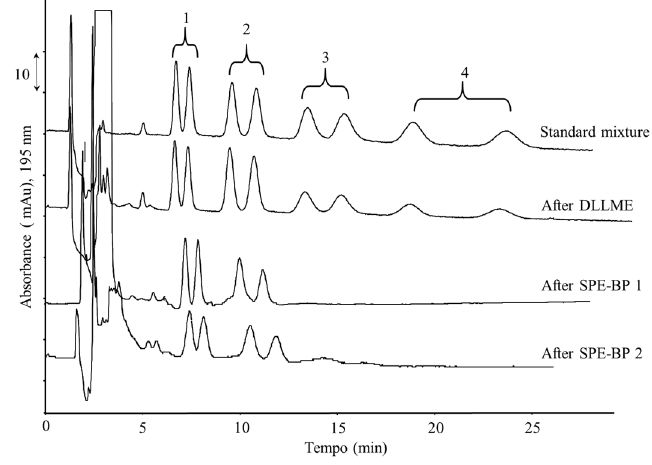
Figure 5. Chromatograms of Milli-Q water spiked with a multistandard solution: mix standard solution; DLLME with a mixture of ACN/CH 3 Cl (500/300 µL) as the dispersing and extracting solvent, respectively; SPE-BP 1, with desorbing solvent MeOH; SPE-BP 2 with desorbing solvent [(CH 3 ) 4 N]Cl hydrate 10 mM MeOH. Experimental conditions: 1—econazole, 2—miconazole, 3—terconazole, 4—ketoconazole.